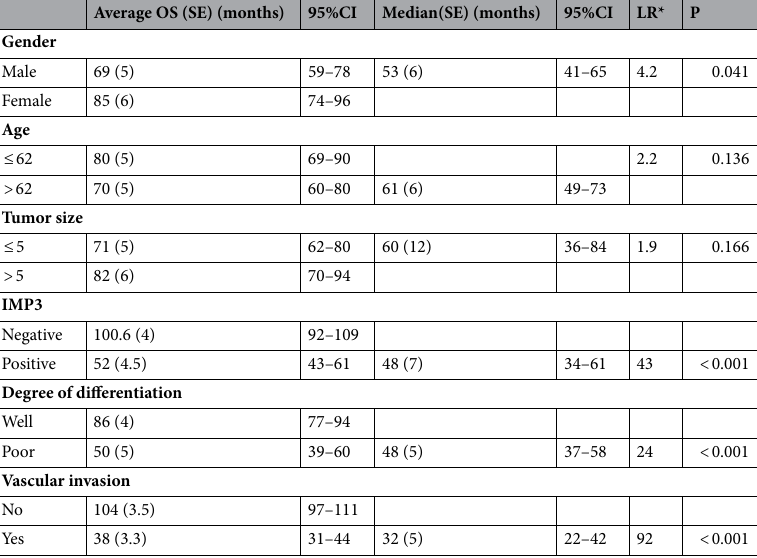
Table 5. Results of analysis overall survival of respondents compared to researched variables. *Log rank